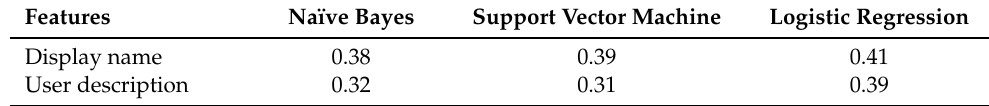
Table 1. Location prediction accuracy using display name and user